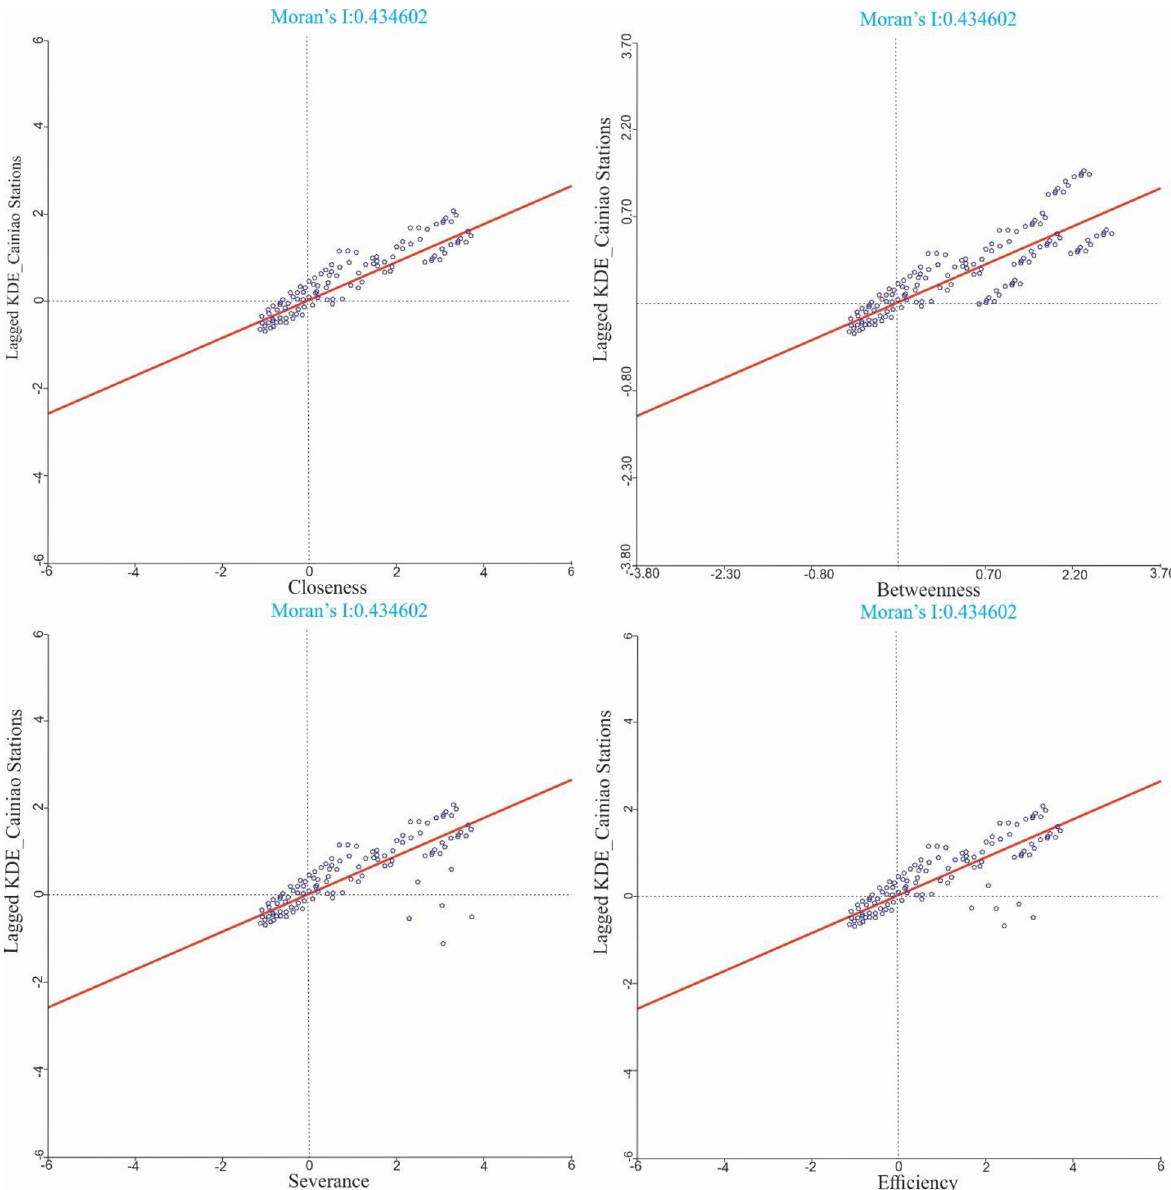
Fig 7. Moran scatter plot of the USN’s centralities and Cainiao